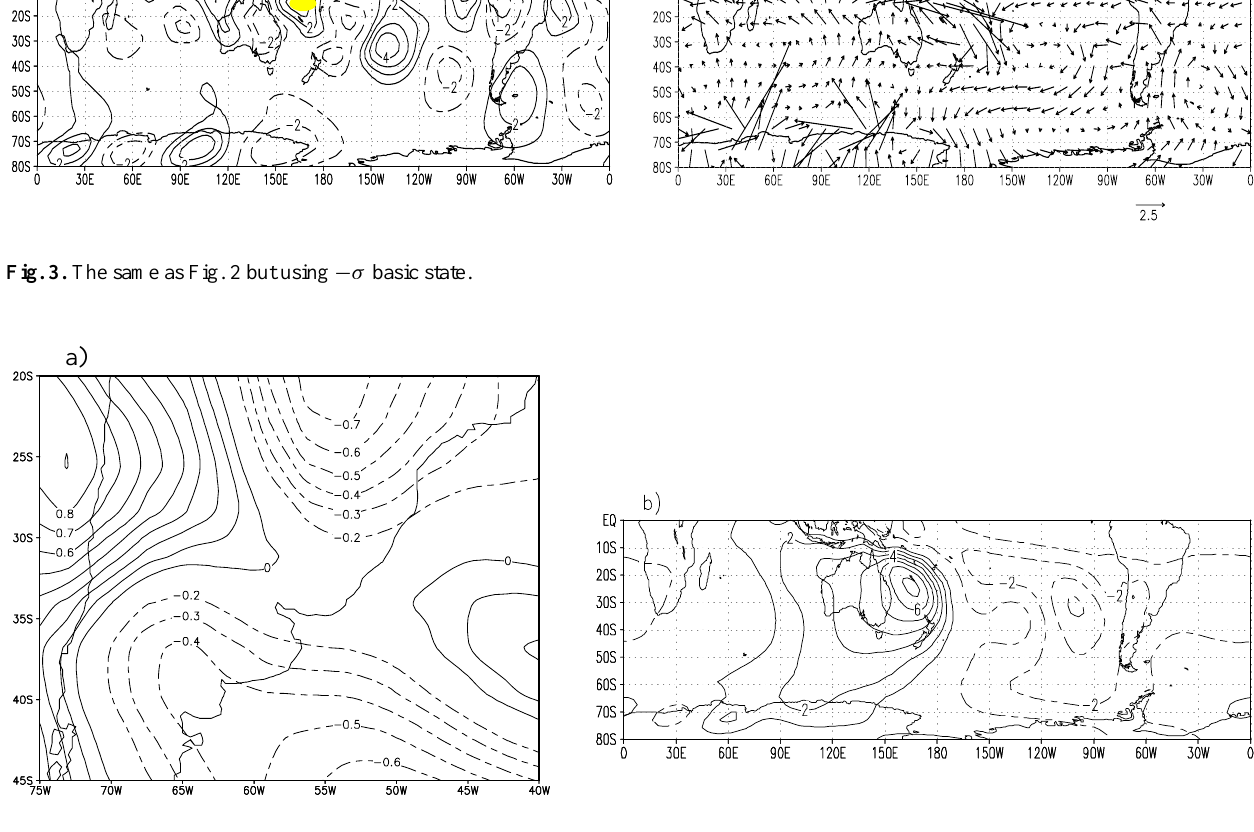
Fig. 4. (a) Surface temperature anomalies ( ◦ C) and (b) stream function anomalies (1 × 10 − 6 m 2 s − 1 ) at 850hPa on day 10 of integration, corresponding to + σ basic state with forcing at 170 ◦ E–15 ◦